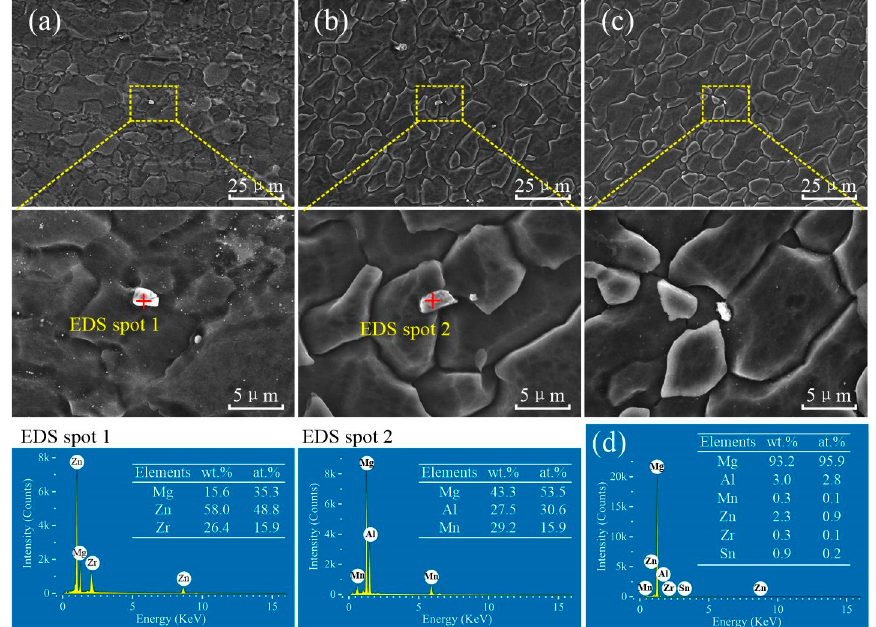
Figure 10. Precipitate particles distribution and EDS scanning results of various stirring subzones of ZK60/ATZ511 joint: ( a ) SZ1; ( b ) SZ2; ( c ) SZ3; ( d ) the full EDS scanning result of the yellow-dotted frame marked in figure ( c ).